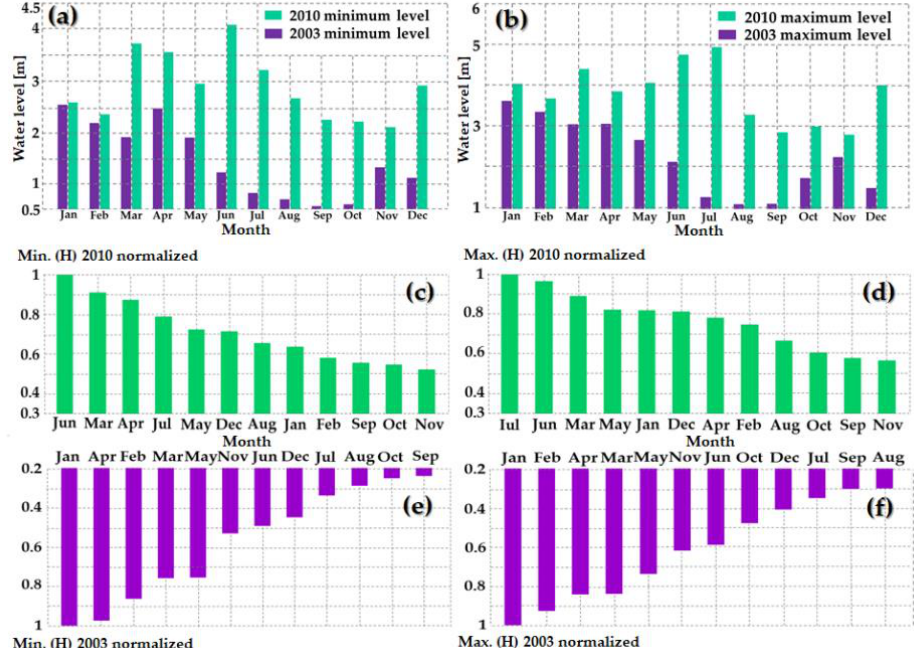
Figure A1. Graphs with monthly distribution of the minimum and maximum water levels of the Danube at the Tulcea hydrometric station in 2003 and 2010. ( a ) Monthly frequency of the minimum water levels; ( b ) monthly frequency of the maximum water levels; ( c , e ) graphs with normalized values corresponding to the monthly frequency of the minimum water levels; ( d , f ) graphs with normalized values corresponding to the monthly frequency of the maximum water